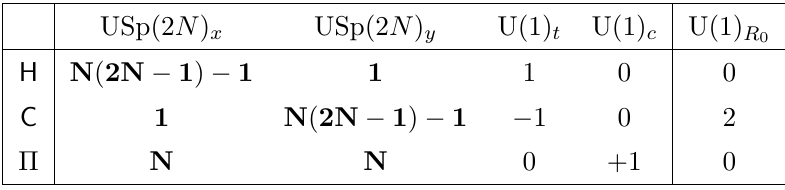
Table 11 . Transformation properties of some of the E [USp(2 N )]